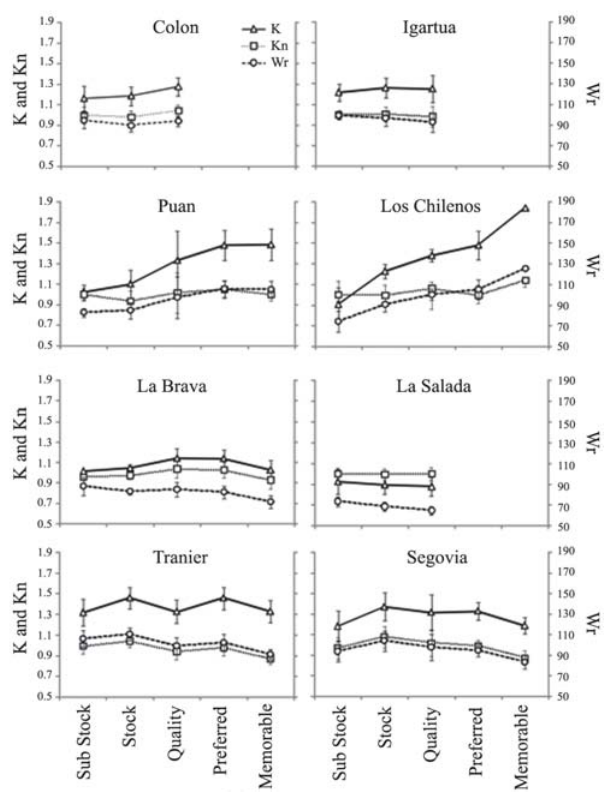
Fig. 3. Relationship between K, Kn and Wr values and length intervals for study